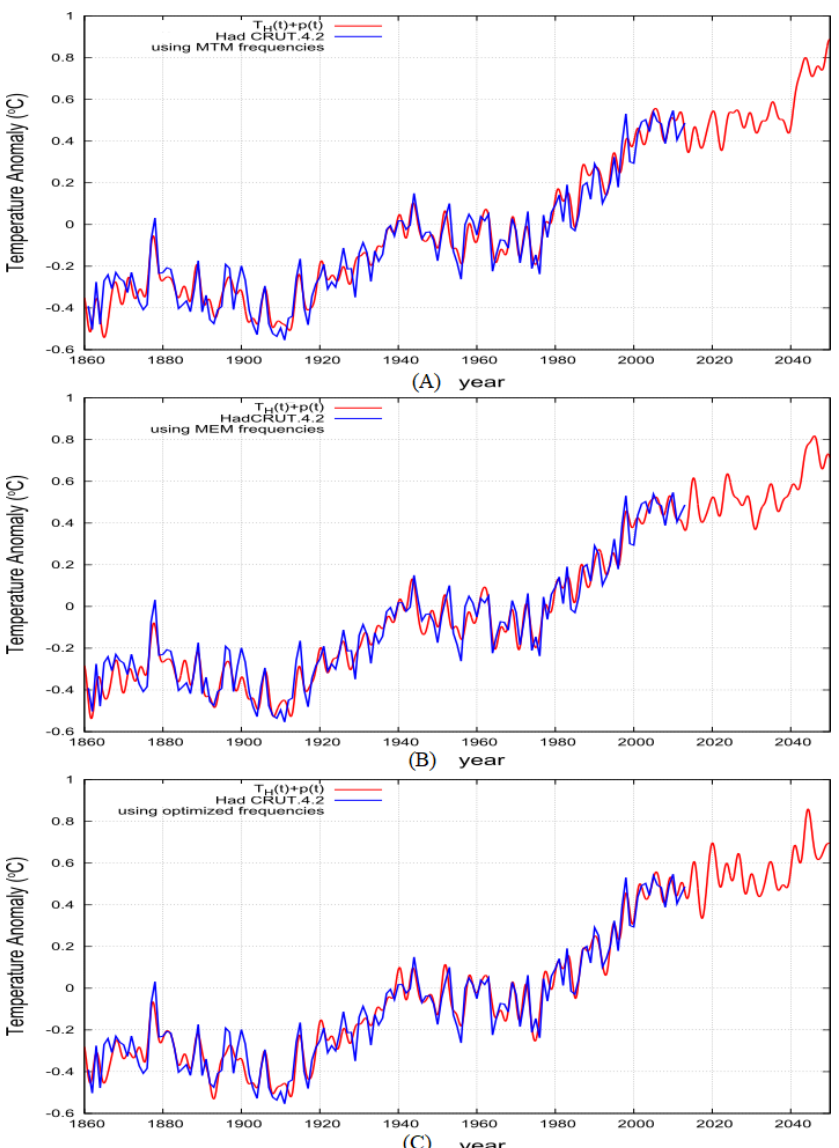
Figure 4. The global surface temperature (blue) against the regression model made of Equation (1) + Equation (2) (red) using: ( A ) The MTM spectral peak frequencies ( rmsr ≈ 0.069 ◦ C); ( B ) the MEM spectral peak frequencies ( rmsr ≈ 0.068 ◦ C); ( C ) the regression optimized frequencies are used ( rmsr ≈ 0.061 ◦ C) . See Table